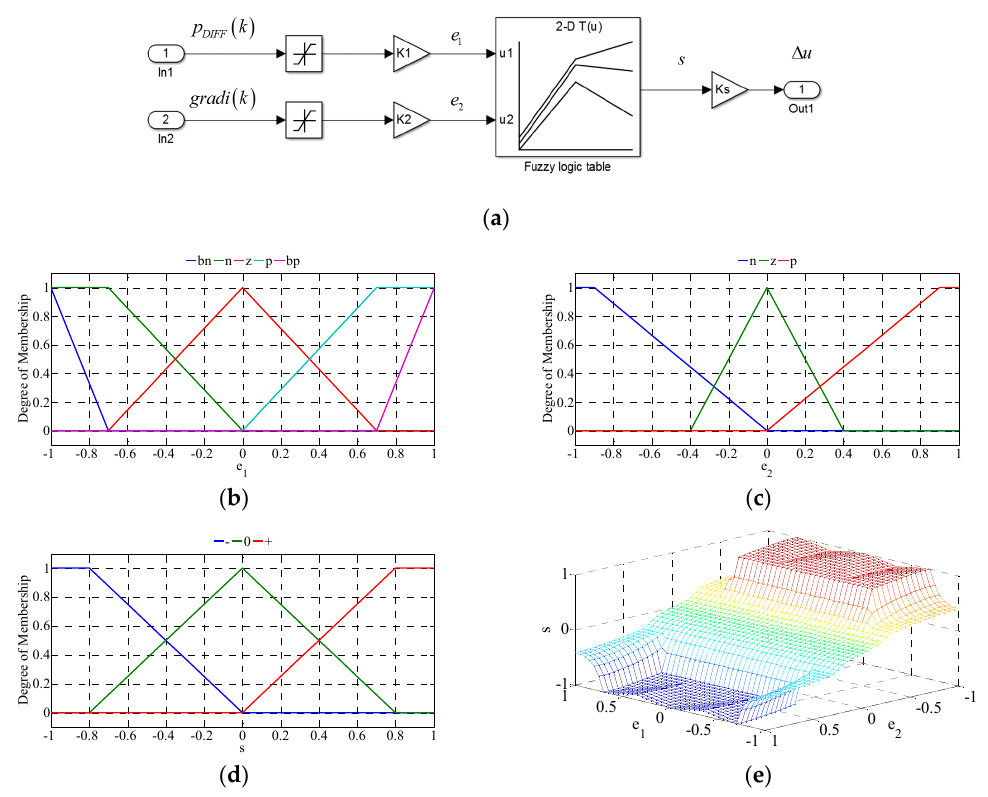
Figure 9. Fuzzy logic: ( a ) structure of fuzzy logic; ( b ) membership of e 1 ; ( c ) membership of e 2 ; ( d ) membership of s ; ( e ) surface of fuzzy reasoning role.